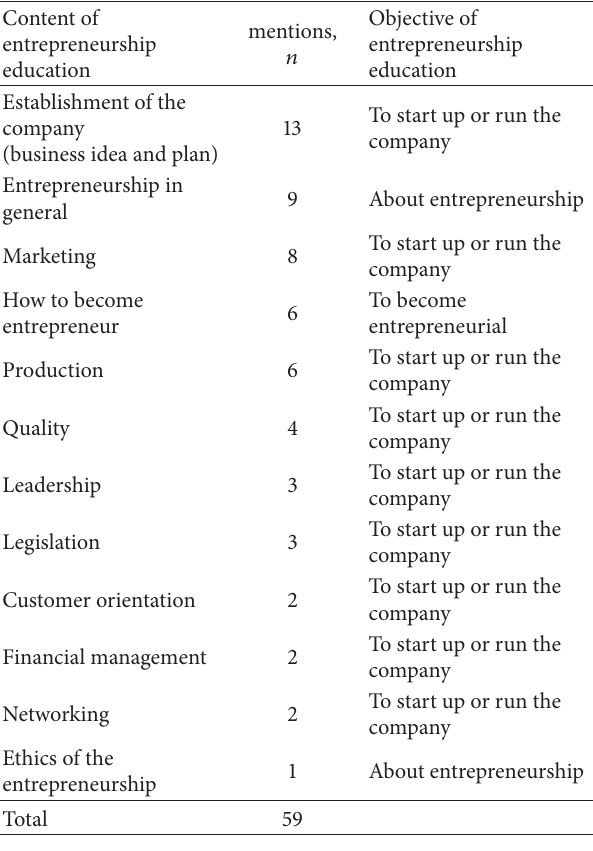
Table 3: Content and objectives of entrepreneurship education ( 𝑛 = how many times the content has been mentioned).